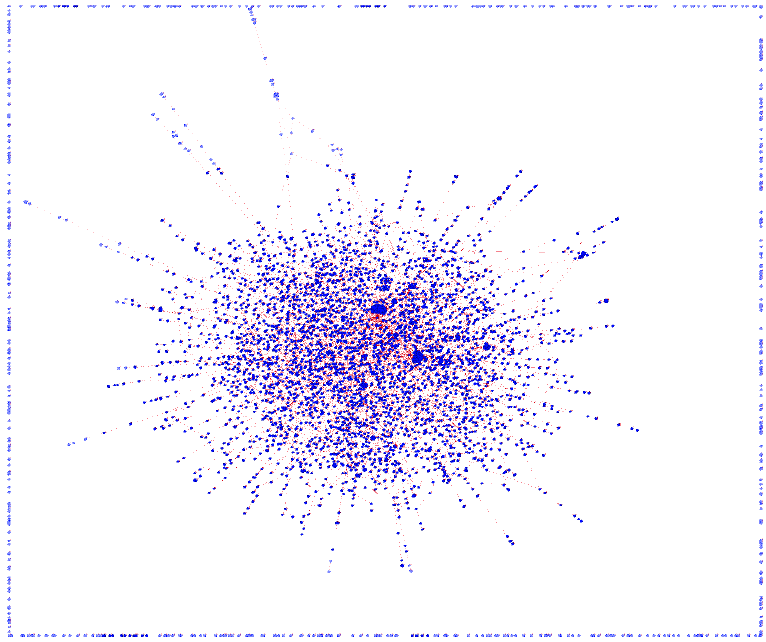
Figure 8. The resulting small world network of the Slashdot social network (Network ‘B’).